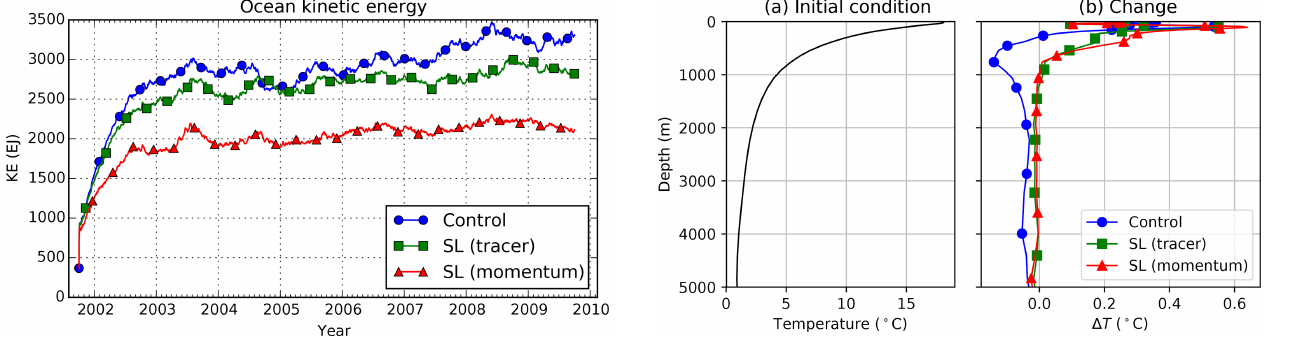
Figure 7. Total ocean horizontal kinetic energy (EJ) over time for the test cases of Sect. 5.2. All of the test cases generally repro- duce the monthly to yearly variability in kinetic energy, but the use of semi-Lagrangian momentum advection results in significantly lower total kinetic energy.